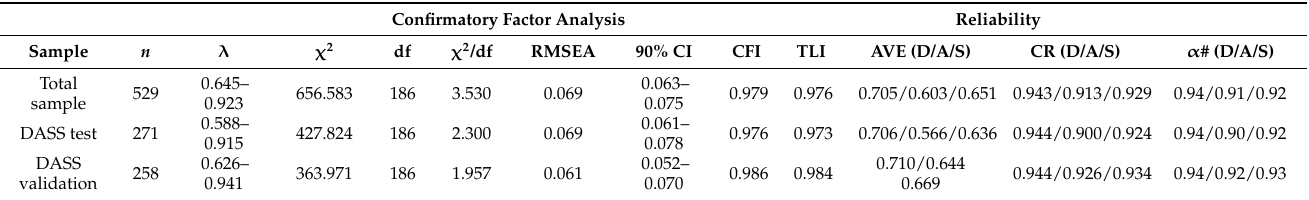
Table 2. Confirmatory factor analysis and reliability of the DASS-21 to different samples.